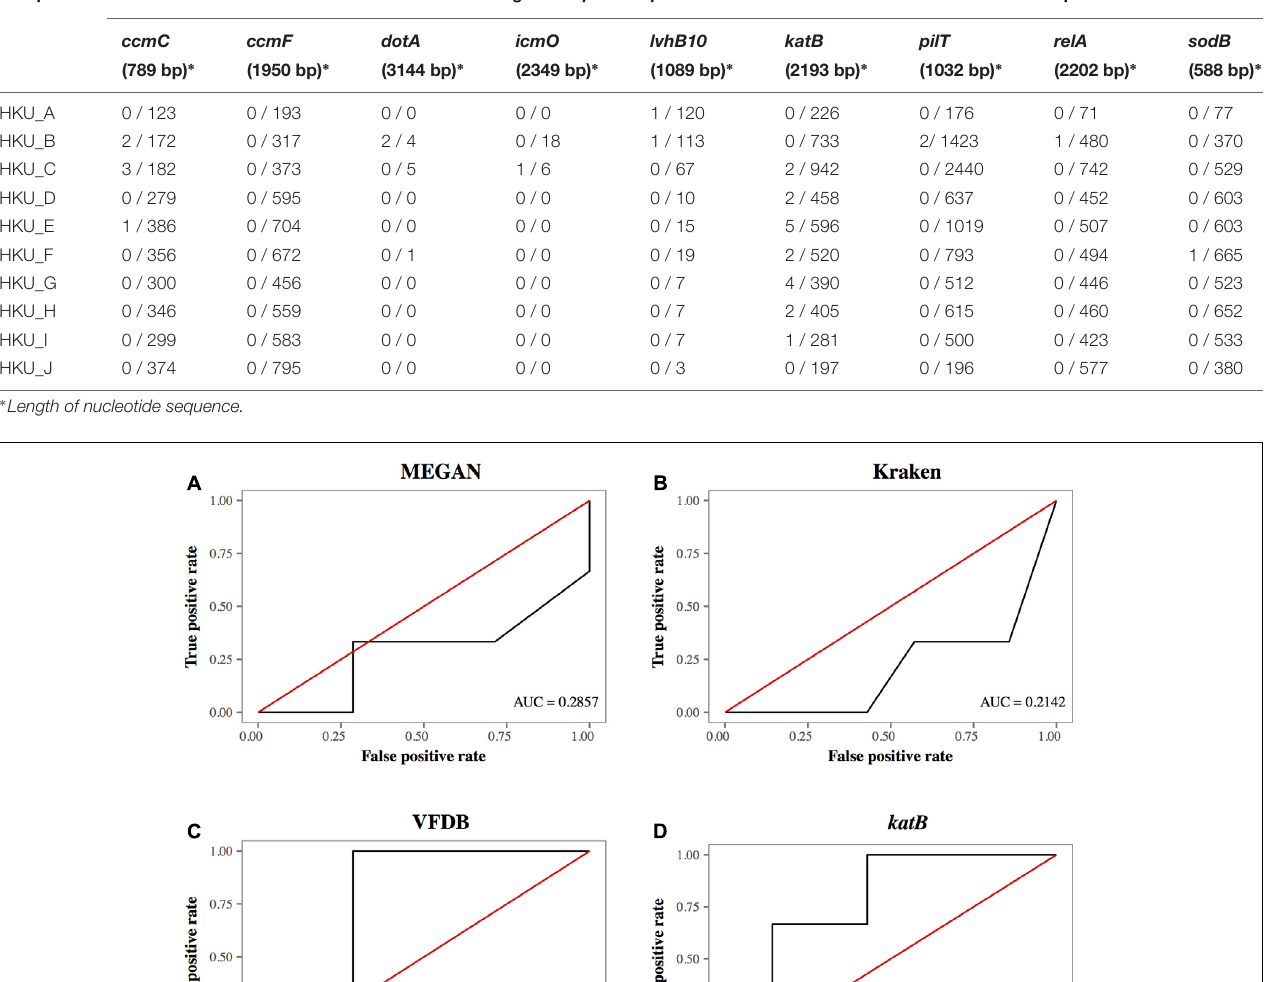
TABLE 3 | Number of shotgun reads identified as Legionella pneumophila using a blastn search against custom databases of virulence factor genes associated with Legionella pneumophila . Samples